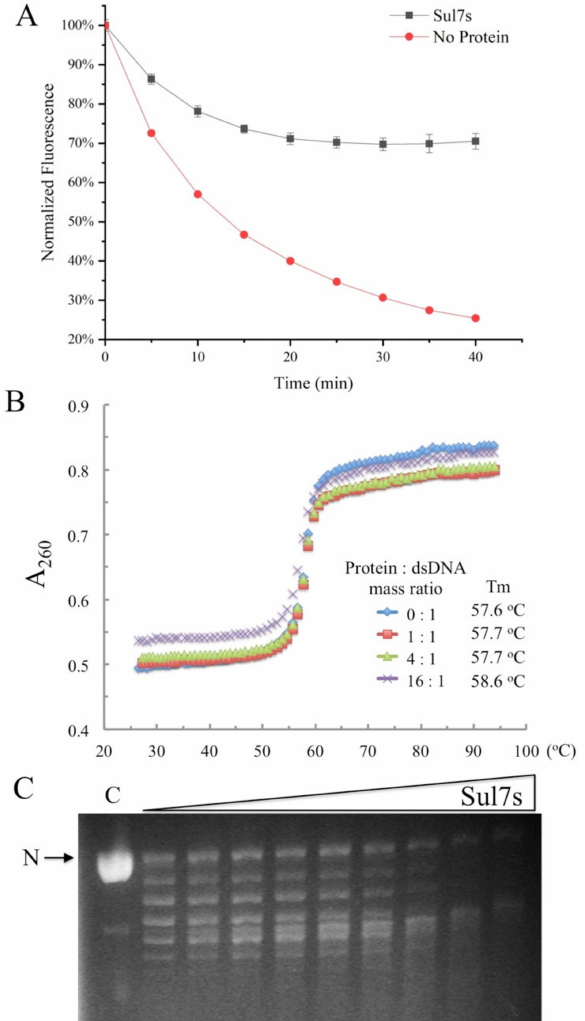
Figure 3. Effects of Sul7s on DNA strands annealing, melting temperature, and DNA supercoils. ( A ) Effects of Sul7s on the kinetics of DNA strands annealing. The 5 (cid:48) -FAM labeled S32-F was